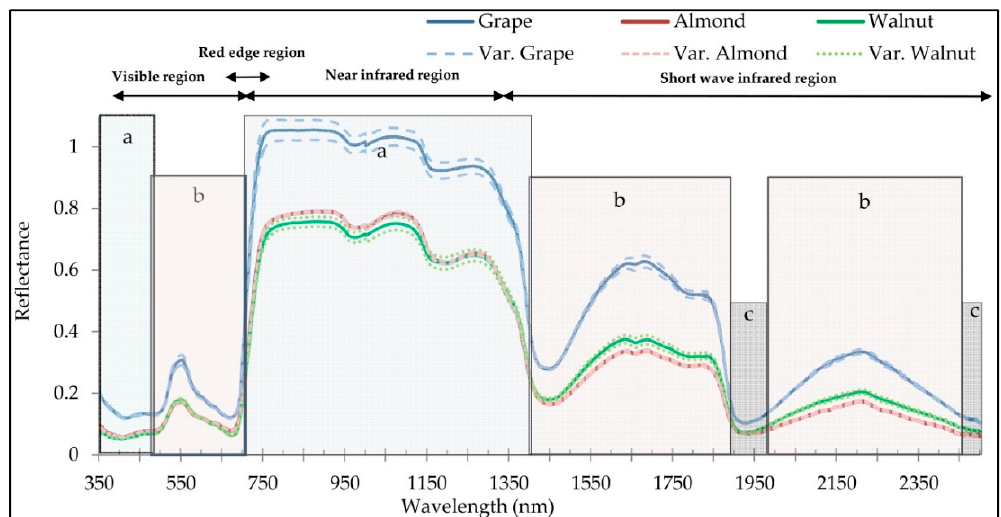
Figure 3. The average of spectral curves and the spectral distribution of the wavelengths in terms of strength in the separation of studied species at the leaf level (at 99% confidence level); Class a : Significant di ff erence between all species, Class b : Significant di ff erence between grape–almond and grape–walnut; Class c : Significant di ff erence between grape and